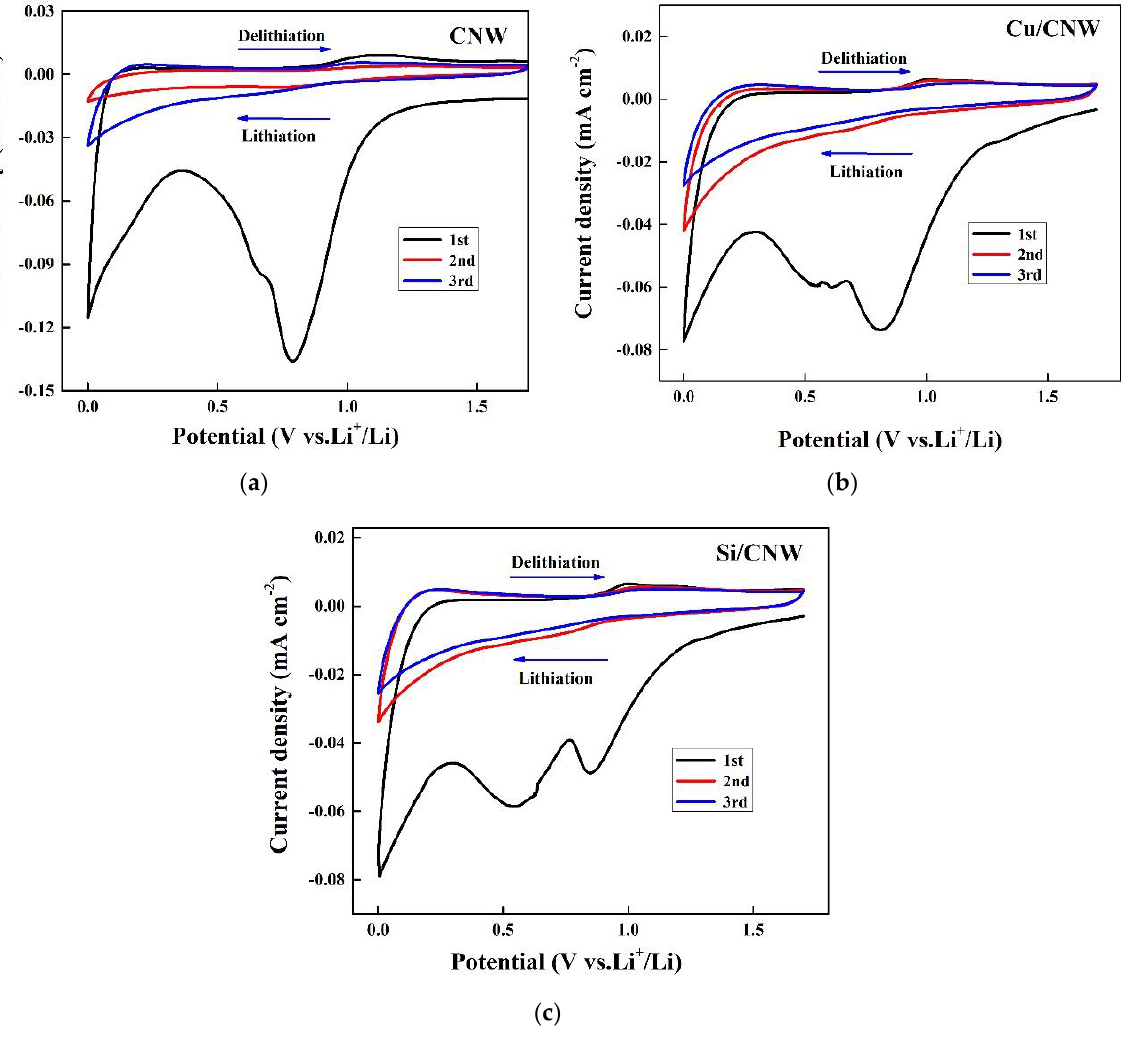
Figure 7. CV graphs of ( a ) CNW, ( b ) Cu − CNW, and ( c ) Si − CNW for 1, 2, and 3 cycles.